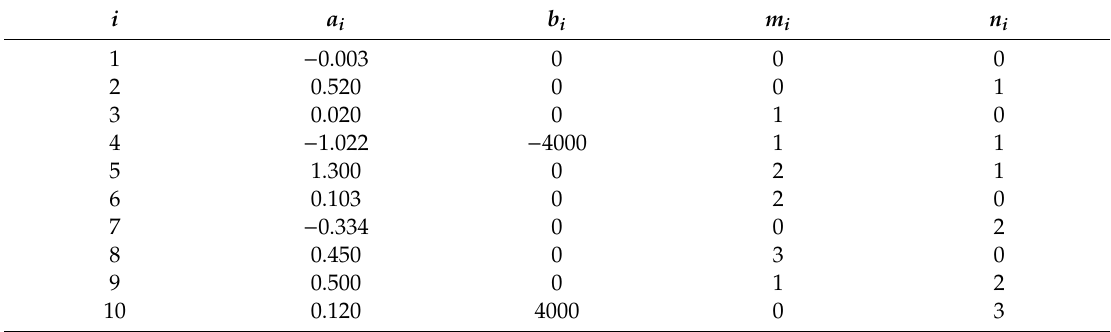
Table A1. Numerical case study parameter values for the motor power loss